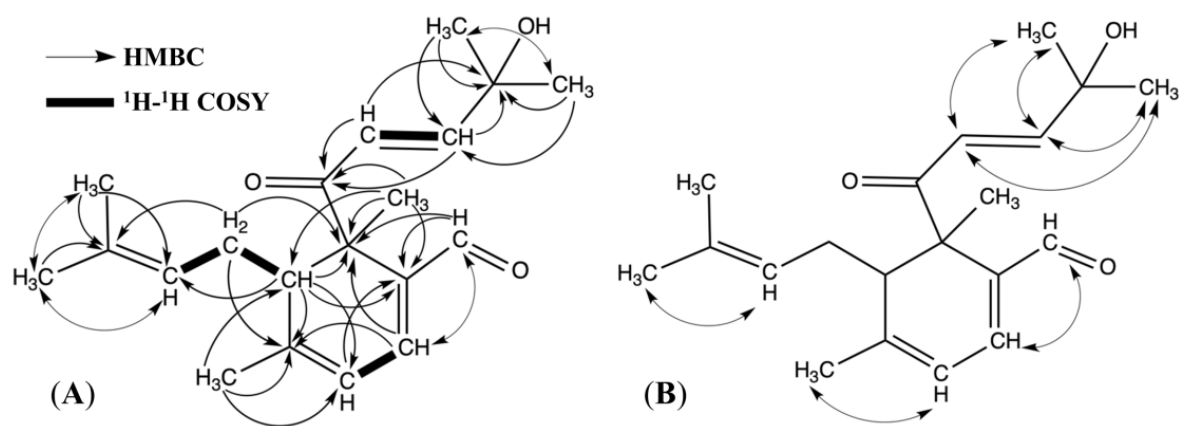
Figure 2. HMBC and 1 H- 1 H COSY correlations ( A ) and NOESY correlations ( B ) of